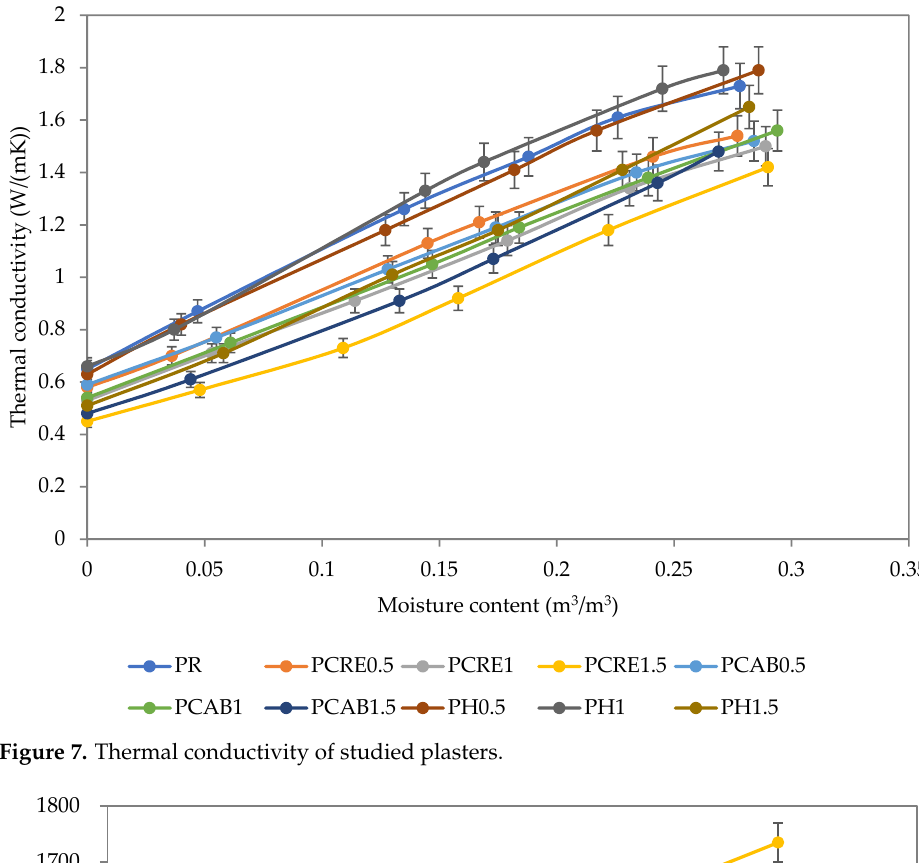
Figure 7. Thermal conductivity of studied plasters.